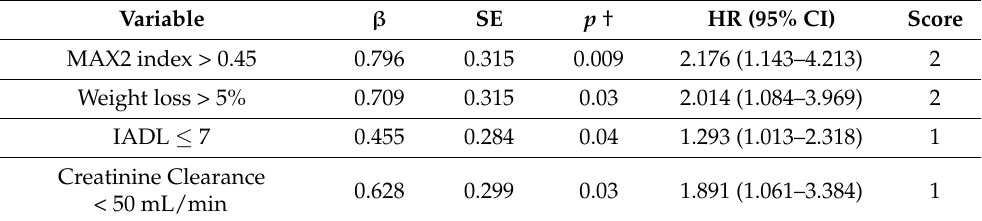
Table 3. Variables significantly associated with toxicity grade